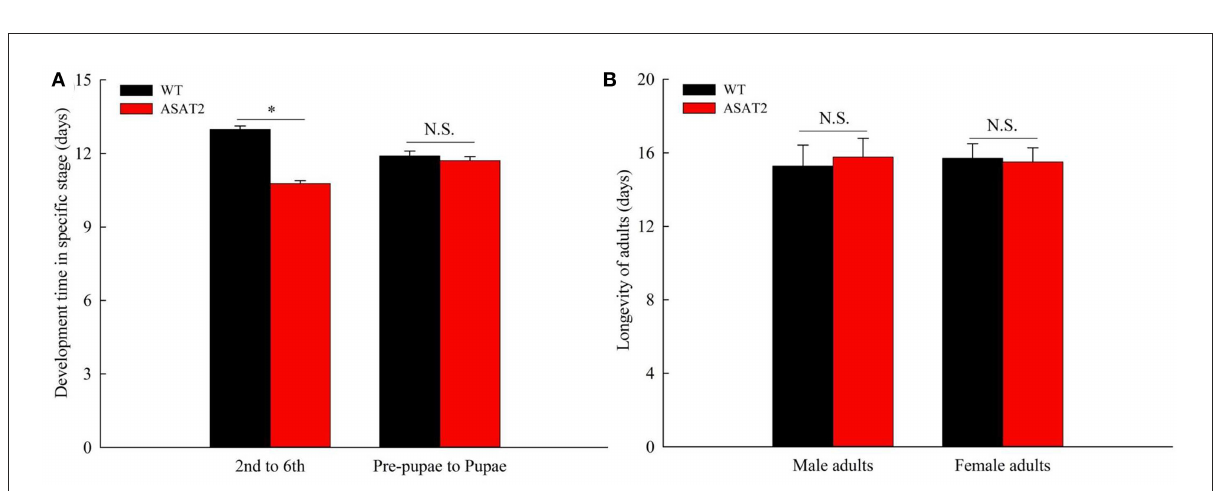
FIGURE3 Development time (A) and longevity of adults (B) of the F 0 generation on WT and ASAT2 plants of N. benthamiana . Values are presented as means ± SE. Asterisks above error bars indicate significant differences ( P < 0.05), and n.s. indicates not significant ( P >